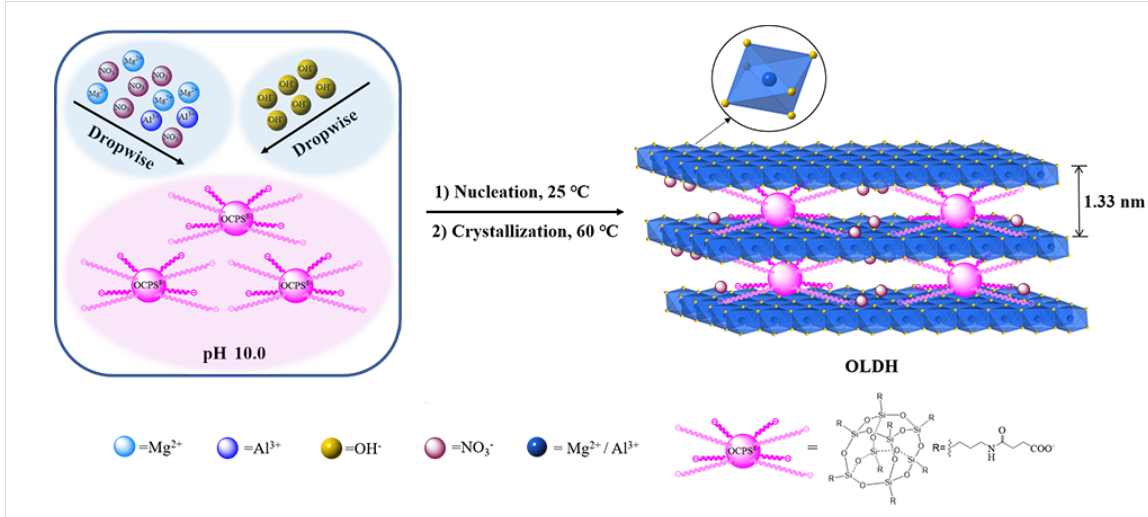
Scheme 2: Schematic diagram of the synthesis of OLDH.